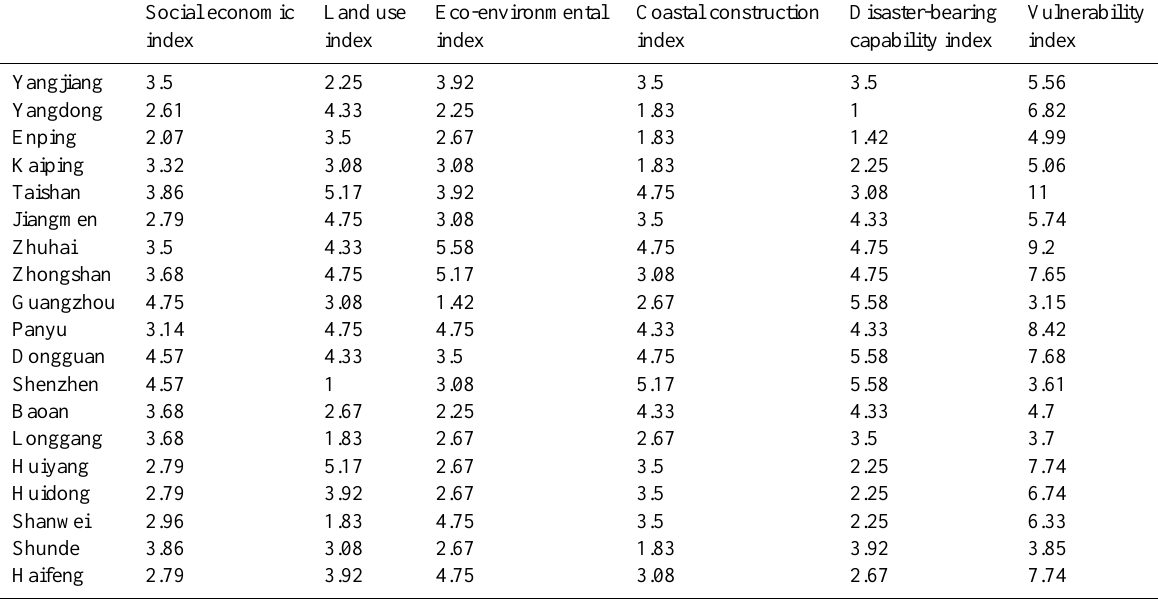
Table 2. The vulnerability indexes of storm surges in 19 coastal counties and districts of Guangdong Province. Social economic Land